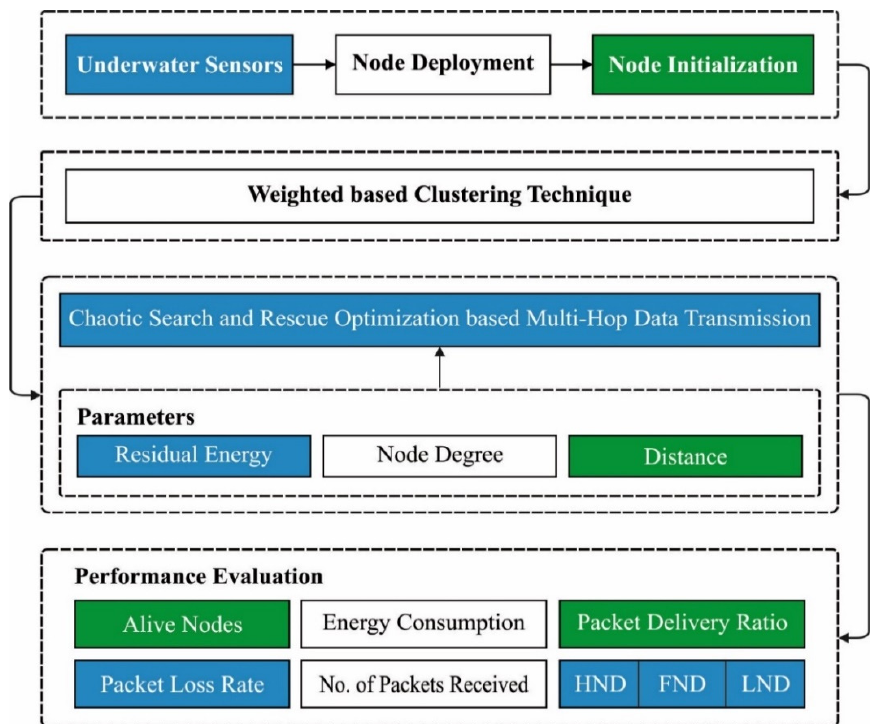
Figure 1. Overall process of the CSRO-MHDT technique.